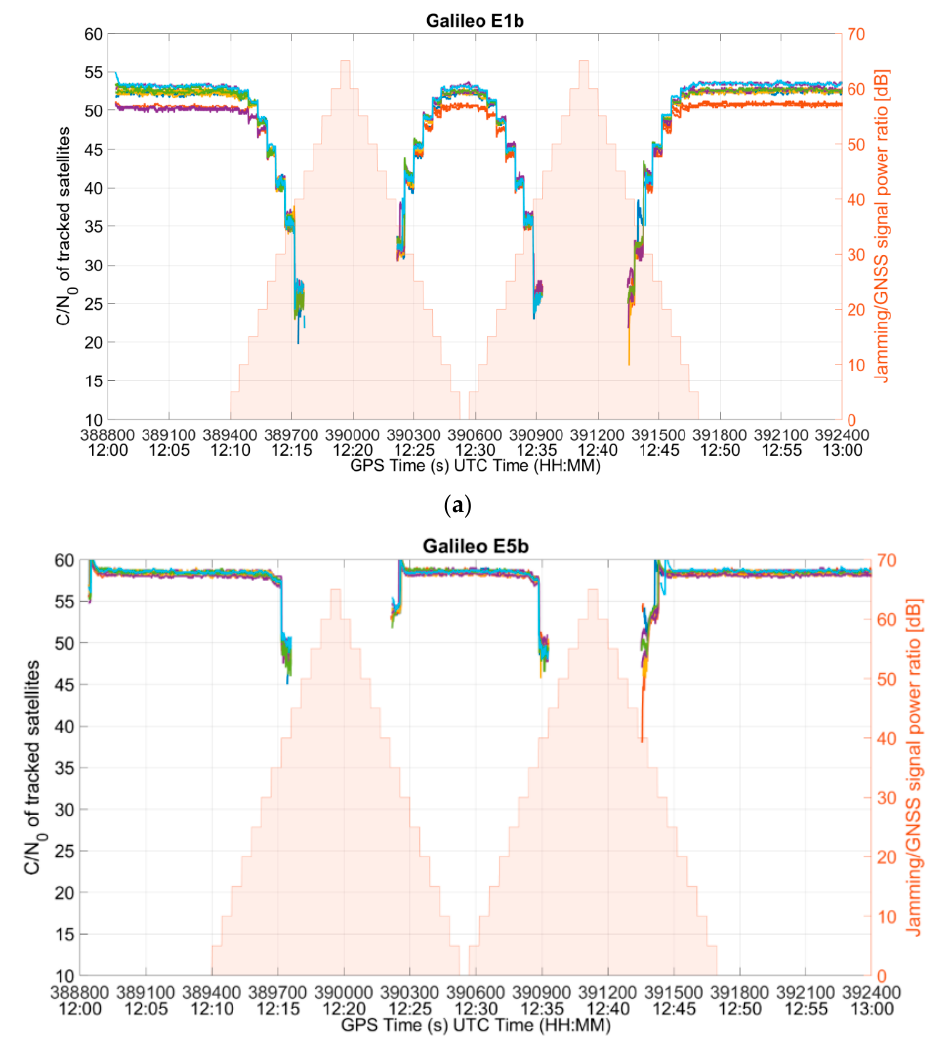
Figure 11. C/N 0 of ( a ) GPS L1, and ( b ) GPS L5 tracked satellites.